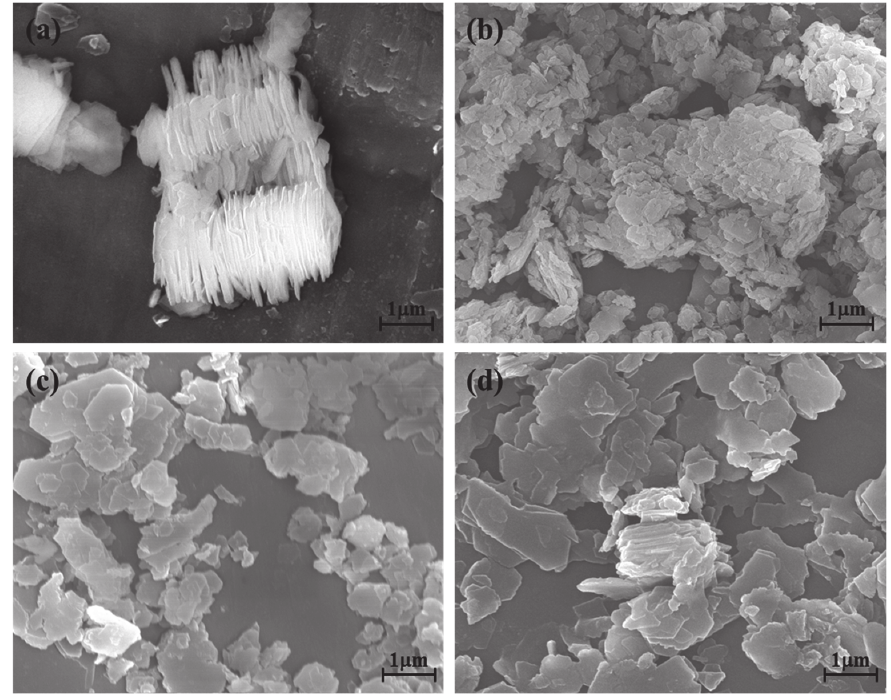
Figure 5. The SEM images of ( a ) original kaolinite; ( b ) the KAc–kaolinite complex; ( c ) the FA–kaolinite complex and ( d ) the DMSO–kaolinite complex.